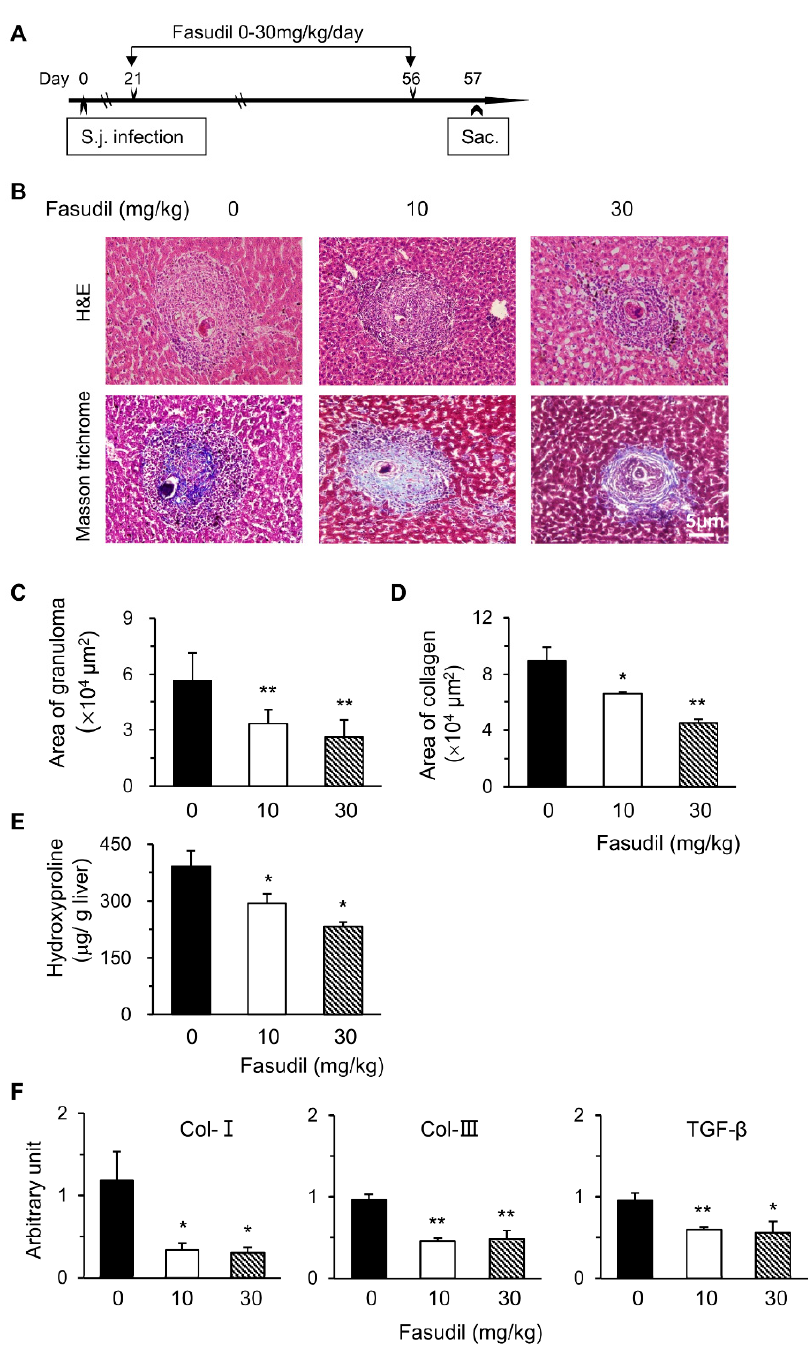
Figure 1. Fasudil therapy suppresses hepatic granuloma formation and fibrosis in mice infected with Schistosoma japonicum . ( A ) Female C57BL / 6 mice were infected with S. japonicum (S.j.) and injected intraperitoneally (i.p.) with fasudil at 0, 10, and 30 mg / kg body weight daily for 5 weeks (day 21–56). Mice were sacrificed 24 h after the last injection. ( B ) Representative hematoxylin and eosin (H&E) and Masson trichrome staining are shown in liver sections. The sizes of ( C ) granulomas and ( D ) collagen areas by Masson trichrome staining around a single egg were measured. ( E ) Hepatic hydroxyproline levels were assayed. ( F ) The mRNA levels of collagen type I ( Col-I ), Col-III , and transforming growth factor-1 (TGF- β 1) in liver tissues were determined using real-time PCR. Data are normalized to an 18S reference and expressed as arbitrary units. Results are representative of three independent experiments ( C – F , means + standard error (SE), n = 5–8). * p < 0.05, ** p < 0.01 vs. PBS-treated (fasudil 0) groups.